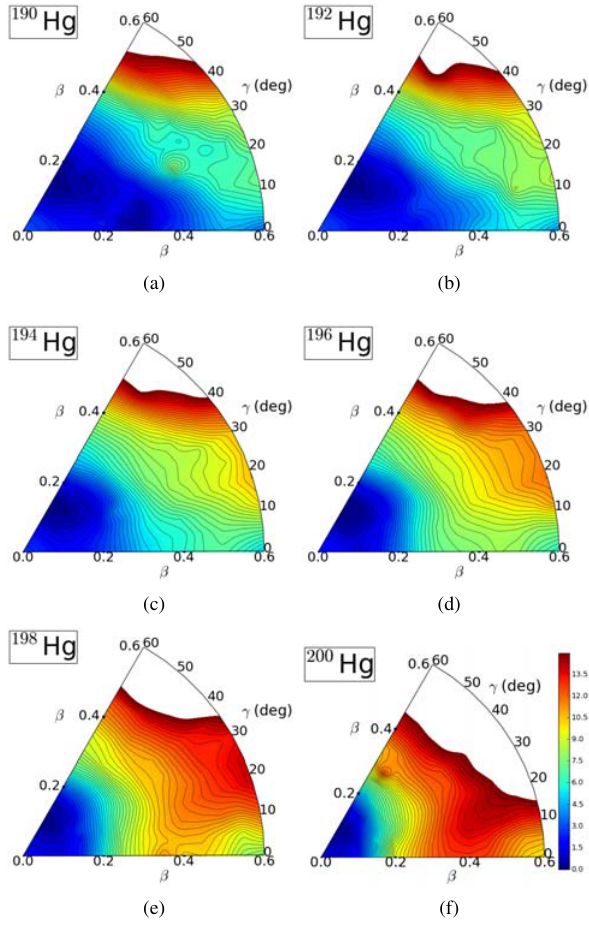
Figure 1: Self-consistent RHB triaxial quadrupole energy surfaces of even-even 190 − 200 Hg isotopes in the β − γ plane (0 ◦ < γ < 60 ◦ ). All energies are normalized with respect to the binding energy of the corresponding ground state.